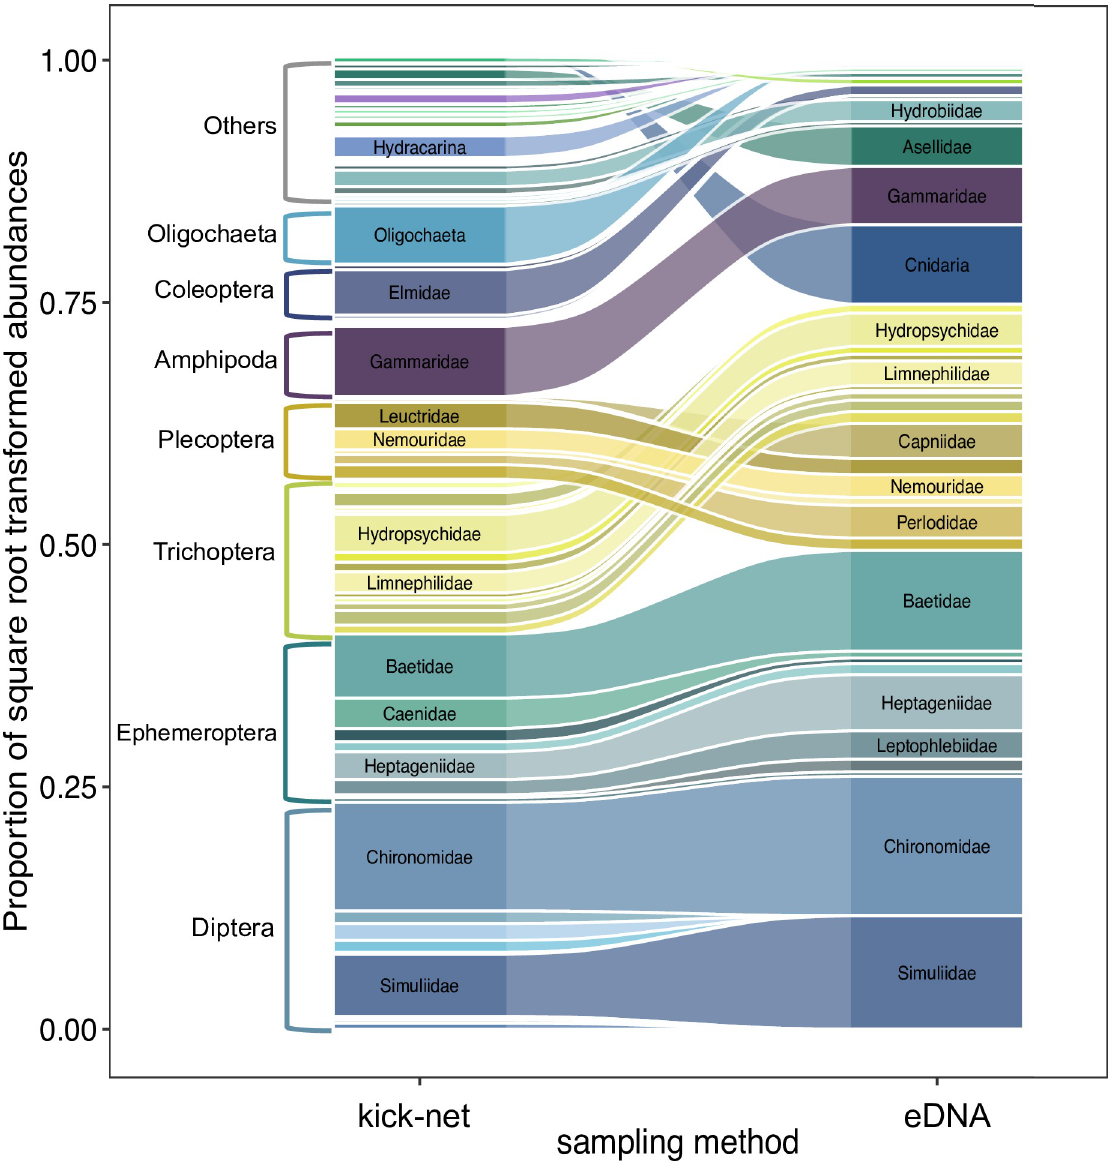
Fig 4. Overall diversity pattern. Proportions of indicator groups detected by kick-net versus eDNA monitoring. The stacked bars indicate proportions of indicator groups inferred by the two methods (proportion of counts for kick-net and of reads for eDNA). For the most common indicator groups, names are given. The flows between the two stacked bars connect families within indicator groups between the methods. A change in flow width indicates a change in proportion depending on the method used.